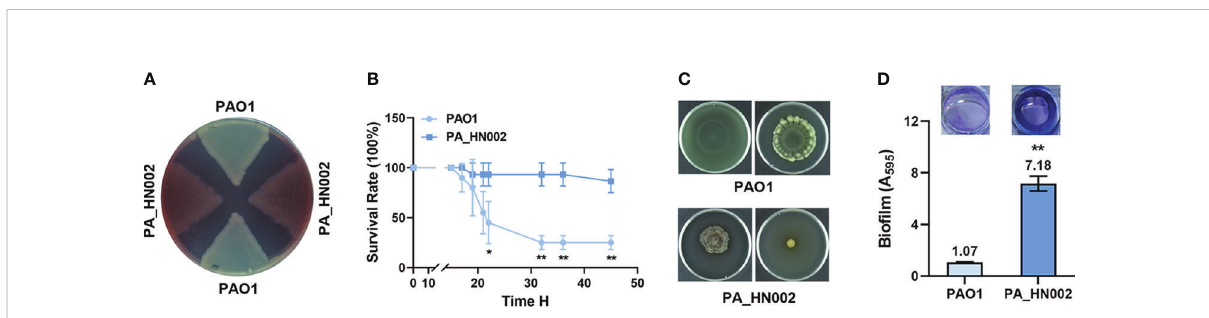
FIGURE 1 Phenotypic comparison between P. aeruginosa PAO1 and PA_HN002. (A) PA_HN002 produced red-colored pigments. (B) Pathogenicity of PAO1 and PA_HN002 was measured in a G. mellonella acute infection model. (C) Swimming (left) and swarming (right) motilities were measured in PAO1 and PA_HN002. Representative pictures of motilities for each strain were shown. (D) Bio fi lm formation of PAO1 and PA_HN002. * P <0.05, ** P <0.01 based on Student ’ s t